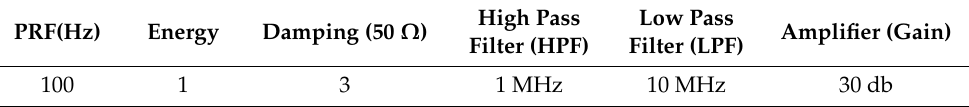
Table 1. The pulser / receiver settings used during the experimental studies.